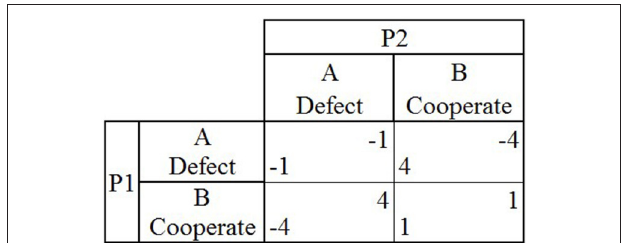
FIGURE 1 | The payoff matrix for the game Prisoner’s Dilemma shows the two players (P1 and P2), the two possible choices they can make during each round (A or B) and the four possible outcomes that can occur during a single round (P1’s payoff located in lower left hand corner, P2’s payoff in upper right hand corner) depending on the choices made by both players in that round.